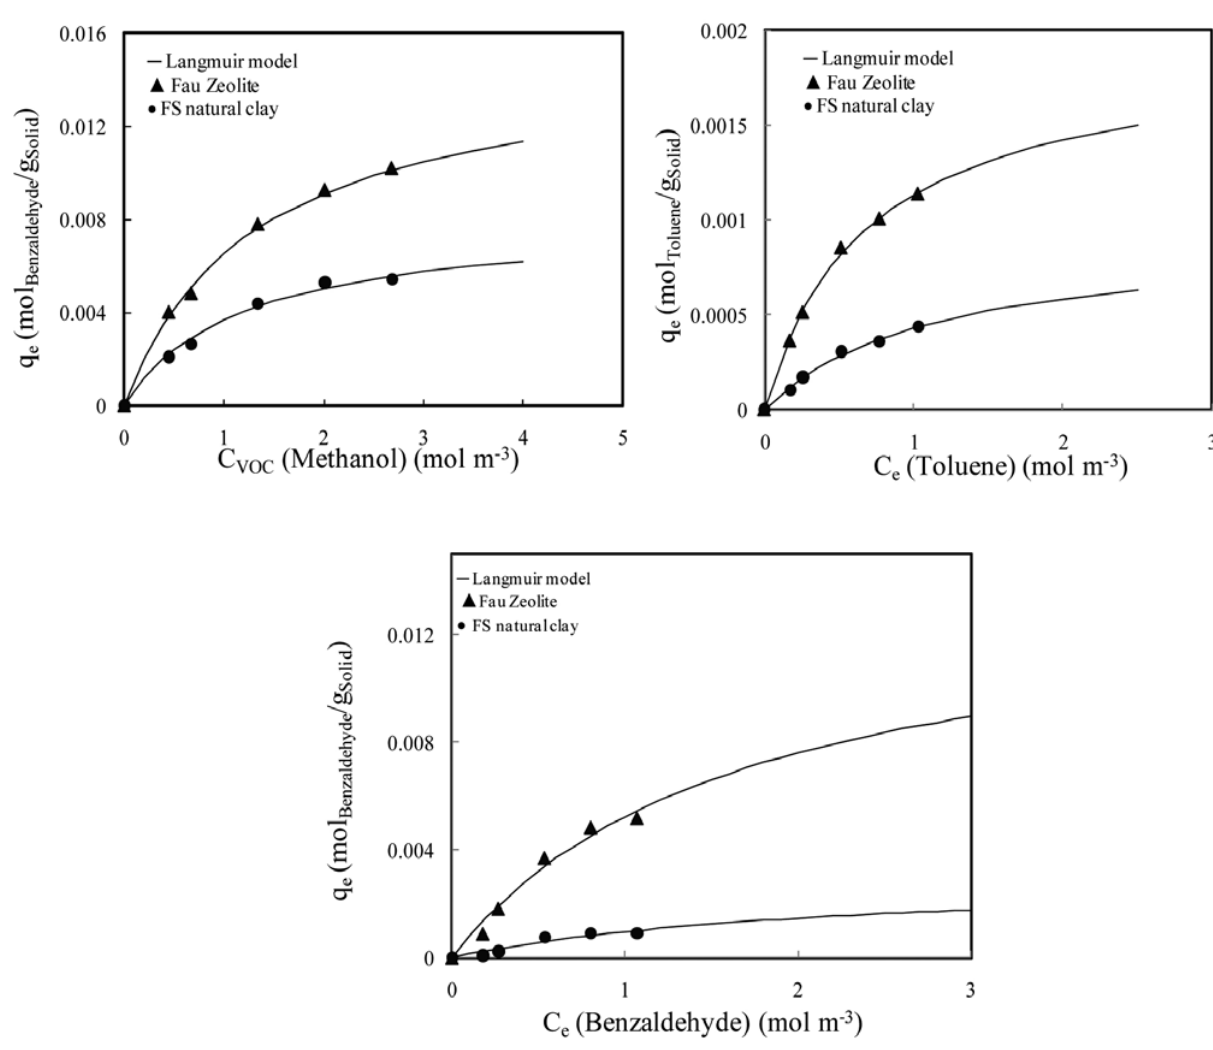
Figure. 7 . Comparison of adsorption capacities toward different VOCs (benzaldehyde, methanol, and toluene) of ( (cid:2) ) FS natural clay and ( (cid:2) ) Fau Y zeolite, (–) represents the fit to Langmuir adsorption